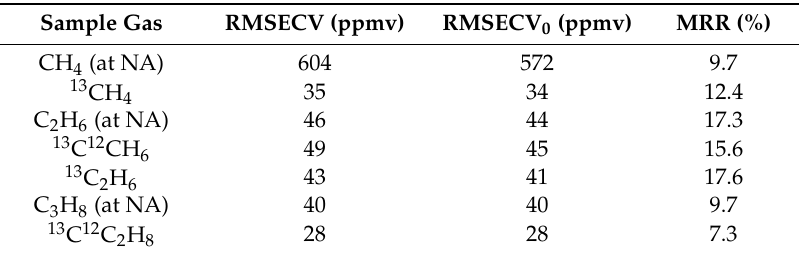
Table 4. Summary of the cross validation (CV)